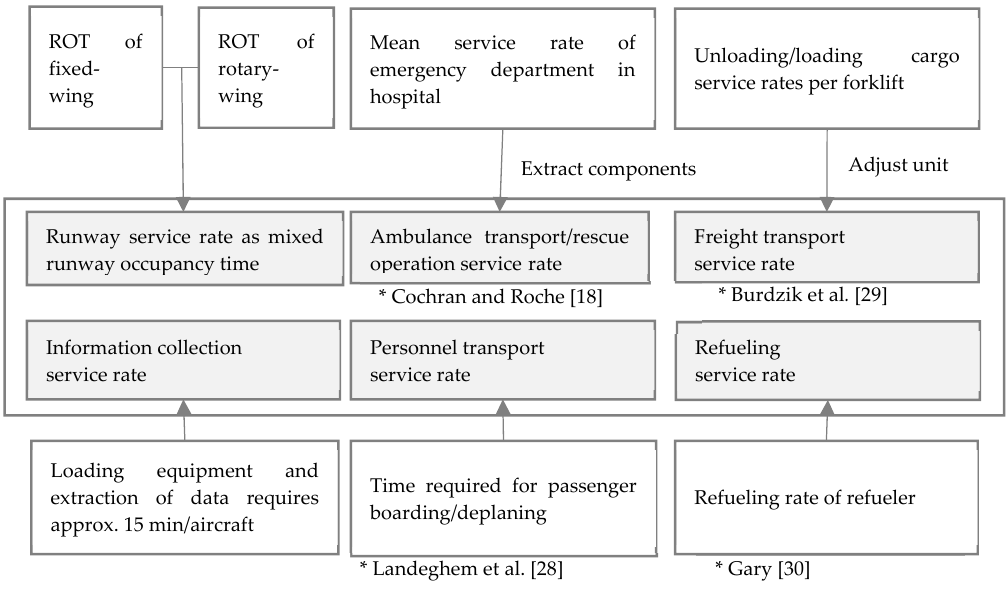
Figure 2. Collection of data on service rate of each activity.